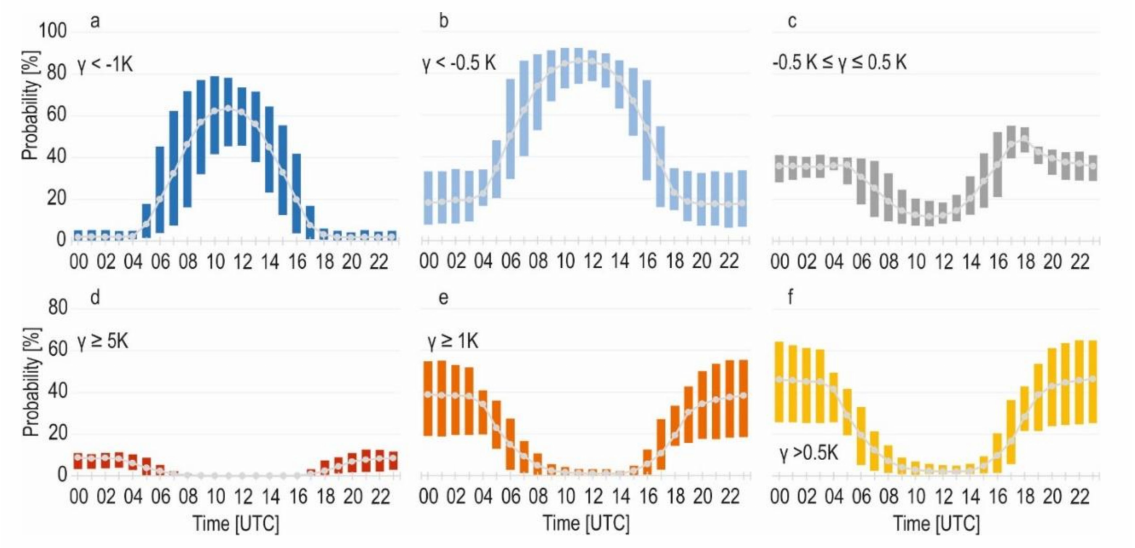
Figure 3. Daily course of conditional probability of air temperature gradients ( γ ) and its seasonal variability; the bottom of the bars—minimum seasonal probability, top of the bars—maximum seasonal probability. Time: 12 UTC = 13:20 local mean solar time. Explanations: ( a )—strong instability, ( b )—and strong instability, ( c )—isothermal conditions, ( d )—strong inversion, ( e )—moderate and strong inversion, ( f )—all